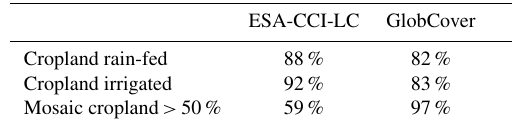
Table 2. User accuracy of the applied land use data sets.